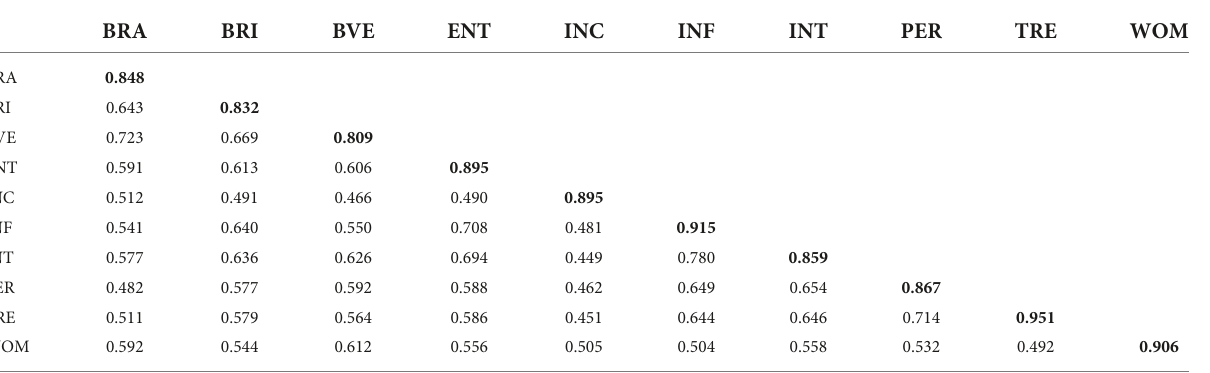
TABLE 6 Forner and Larcker discriminant validity.